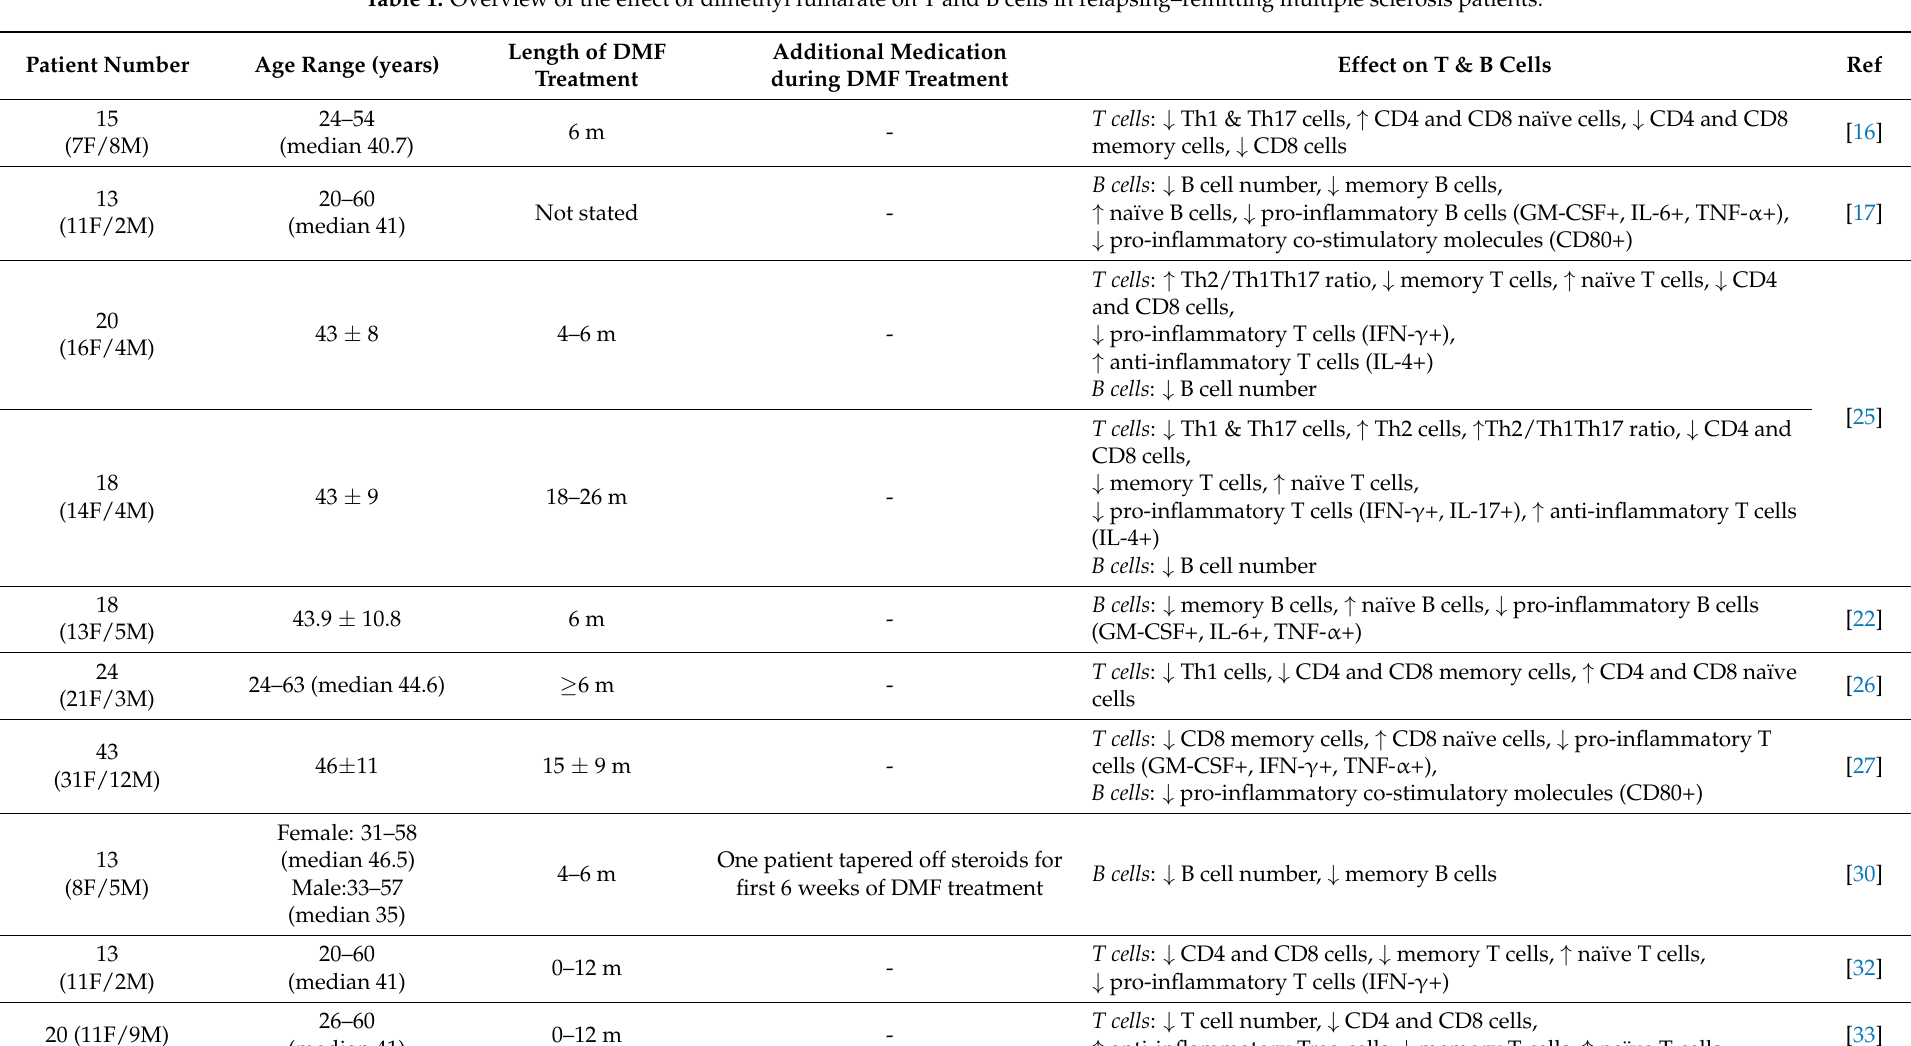
Table 1. Overview of the effect of dimethyl fumarate on T and B cells in relapsing–remitting multiple sclerosis